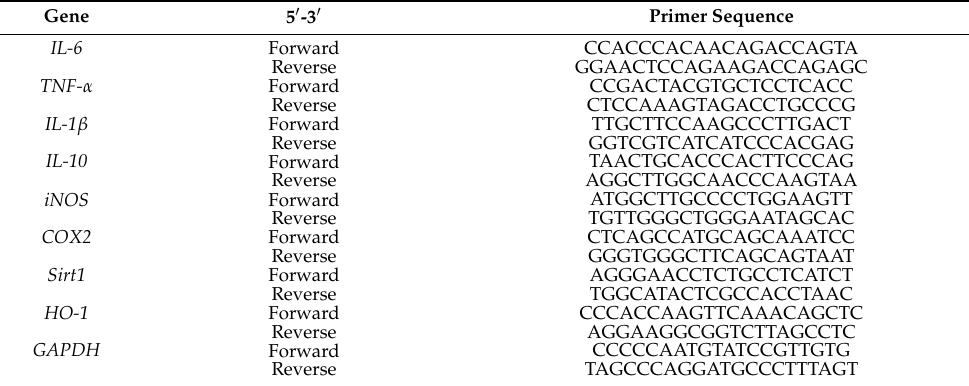
Table 1. Primer sequences used for RT-qPCR